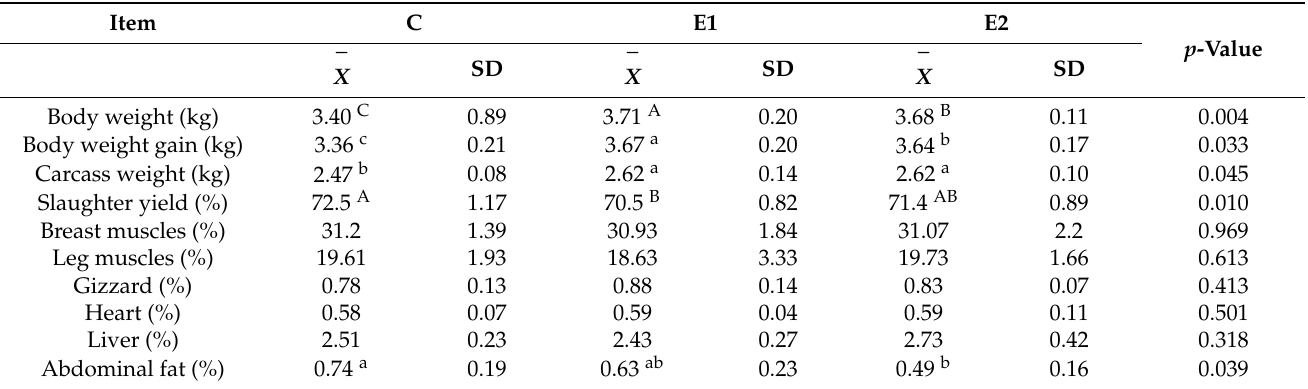
Table 3. Broiler chicken production results, carcass yield, and the proportion of individual elements in chilled broiler carcasses ( n =